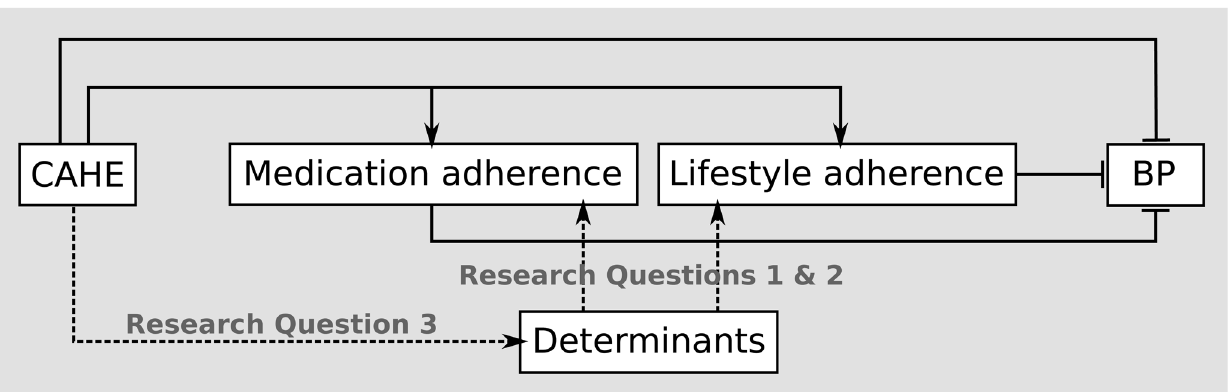
Fig 1. A schematic overview of the scope of this study. Fig 1 legend: A Schematic overview of the scope of this study and the study of Beune et al. [22] Beune et al. showed positive correlations (solid arrows) of the CAHE intervention with adherence to lifestyle recommendations. Additionally, CAHE was shown to lower diastolic blood pressure (blunt arrows). The dashed arrows indicate the research questions of this study. Research question 1 and 2 analyse which determinants are associated with adherence to medication and lifestyle recommendations. Research question 3 answers which determinants the CAHE intervention influences in order to increase adherence to medication and lifestyle